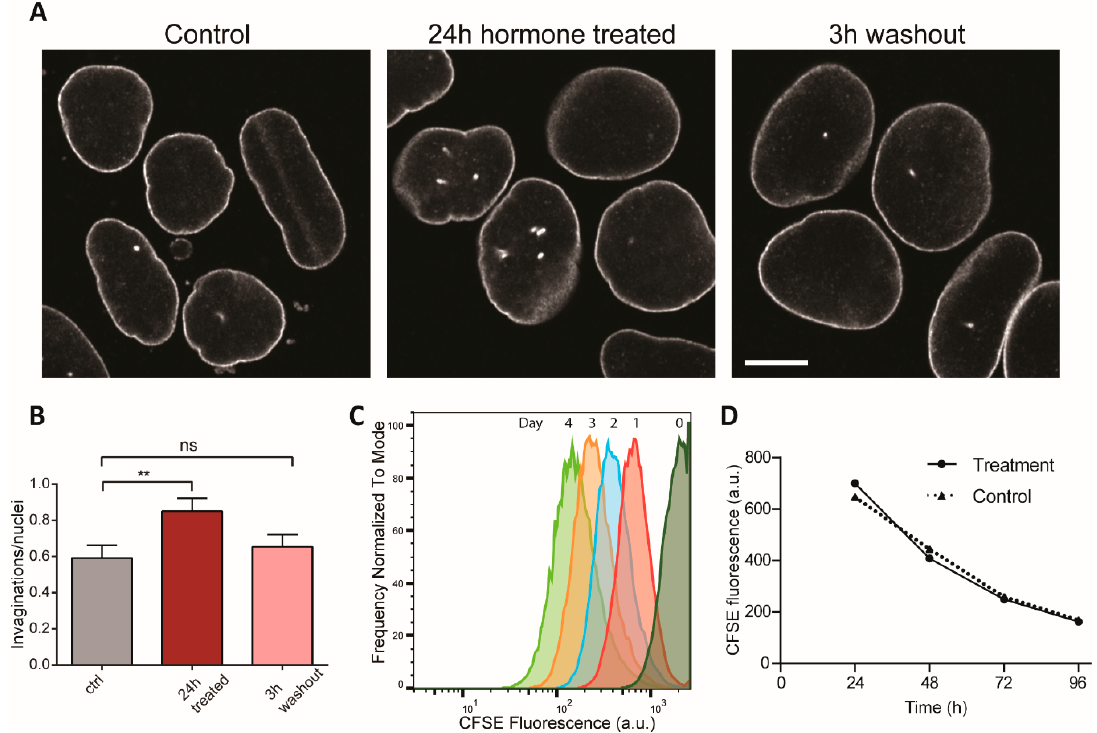
Figure 3. NR formation in endometrial cells is reversible and cell cycle independent. ( A ) NR induction in Ishikawa cells treated with oestrogen and progesterone for 24h and then subjected to 3 h washout in hormone-free media. Nuclei immunostained with anti-Lamin B1-Cy5. Scale bar 10 µm. ( B ) NR abundance quantification. Three replicates total, n = 242, 262, 203, respectively. ** for p < 0.01; ns for non-significant. Error bars represent SEM. ( C ) Hormone addition or removal does not affect cell division rate. Normalised frequency of CFSE fluorescence of Ishikawa cells measured by flow cytometry. Hormones were added for 48 h then removed for another 48 h. Average cell number per profile = 28,000. Individual flow cytograms in Supplementary Figure S1. ( D ) Average CFSE loss over time of treated and control samples reveal non-significant difference in cell proliferation rates.